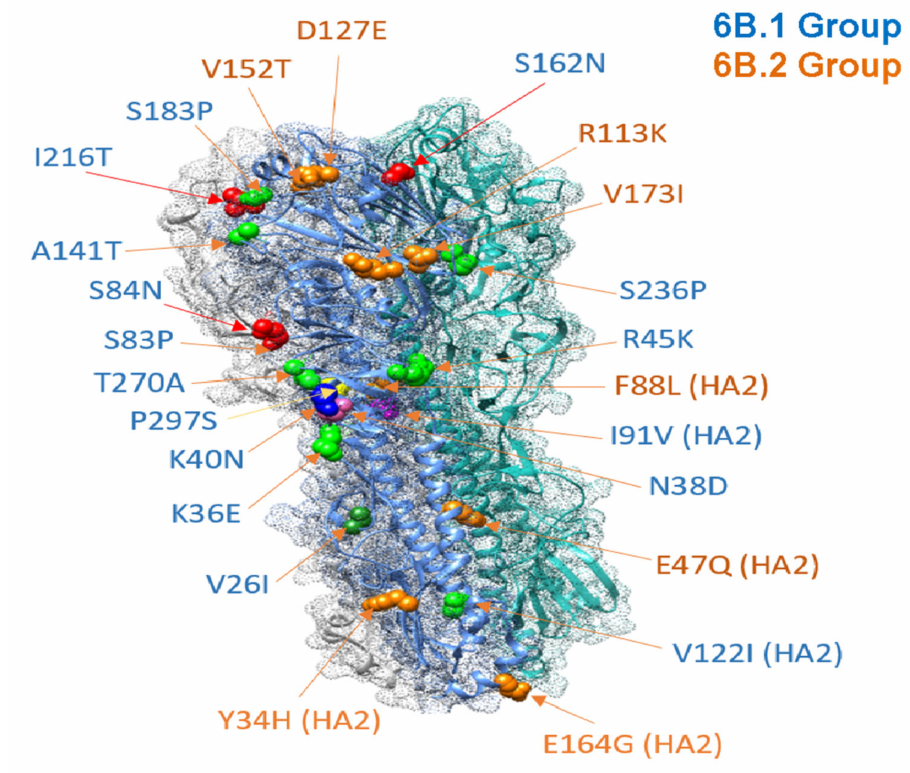
Figure 3. Model 3D structure of the A(H1N1)pdm09 HA protein with the substitutions that occurred in 2015/16 in strains isolated in Ukraine. Structure (PDB ID—3LZG) was modeled using Chimera software and labeled according to H1 6B.1 (blue) or 6B.2 (orange) genetic